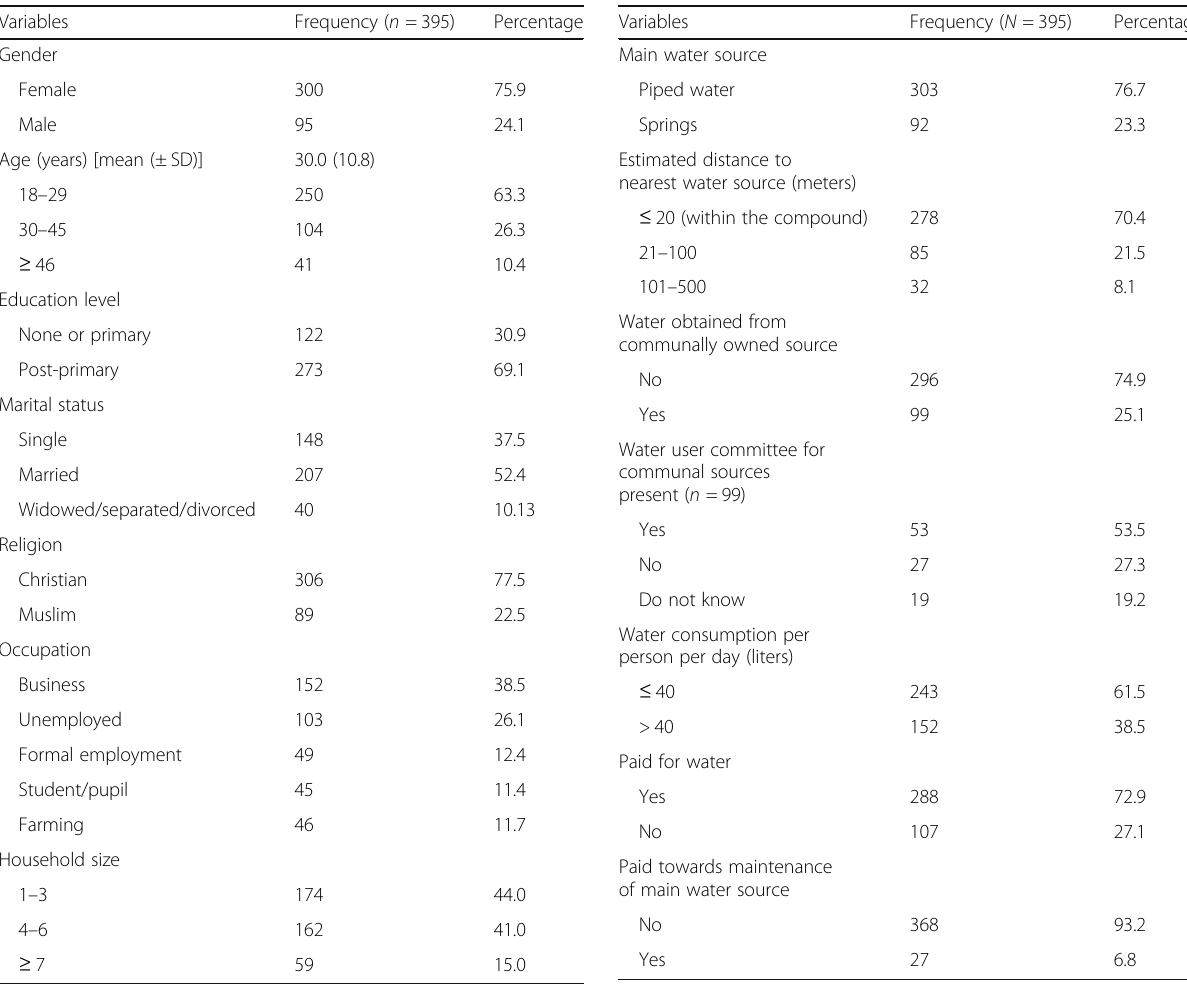
Table 2 Sociodemographic characteristics of participants Table 3 Sources of domestic water and their